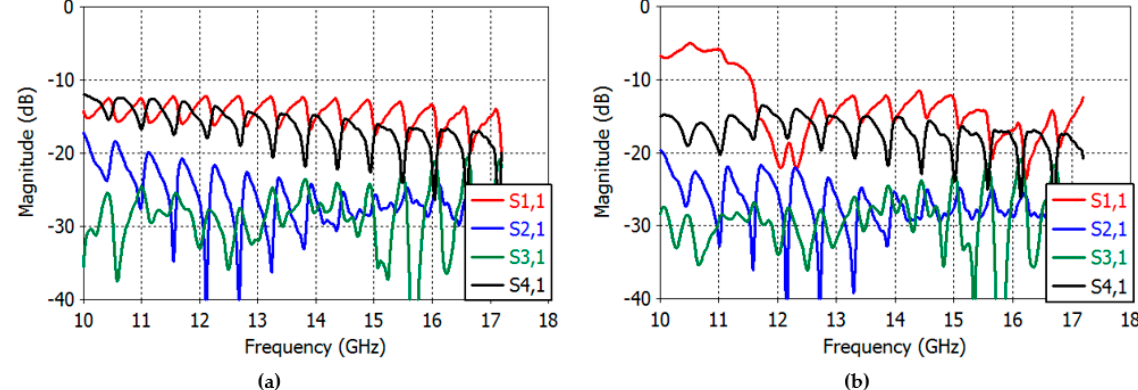
Figure 9. Reflection and transmission coefficients of the feed excited by TE 10 modes ( a ) and by coaxial probes ( b ) illuminating the truncated reflector.